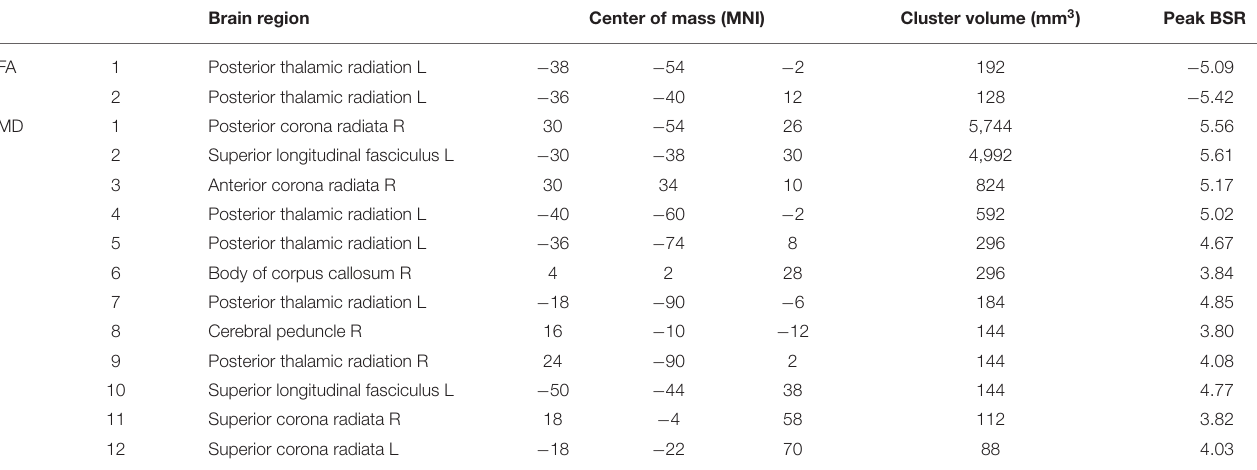
TABLE 3 | White matter clusters with significant salience effects, indicating regions where fractional anisotropy (FA) and mean diffusivity (MD) are associated with appraisal mismatch network expression scores; the identified regions correspond to the brain maps shown in Figures 3A,C , respectively. Brain region Center of mass (MNI) Cluster volume (mm 3 ) Peak BSR